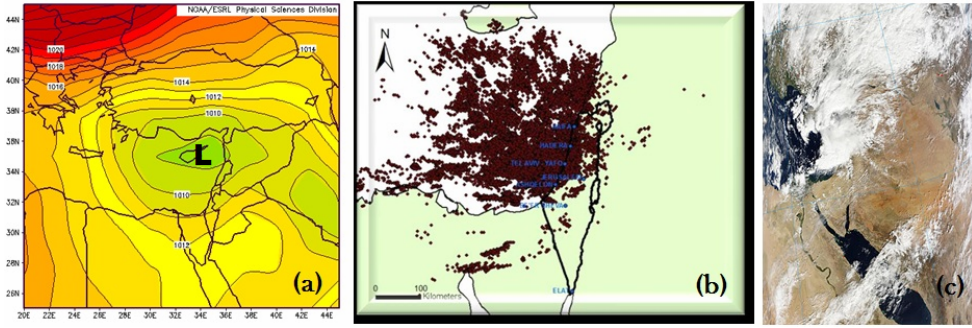
Fig. 8. As in Fig. 7 but for the “maritime” type, 30 October 2009. The MODIS satellite image was taken at 08:20 UTC.